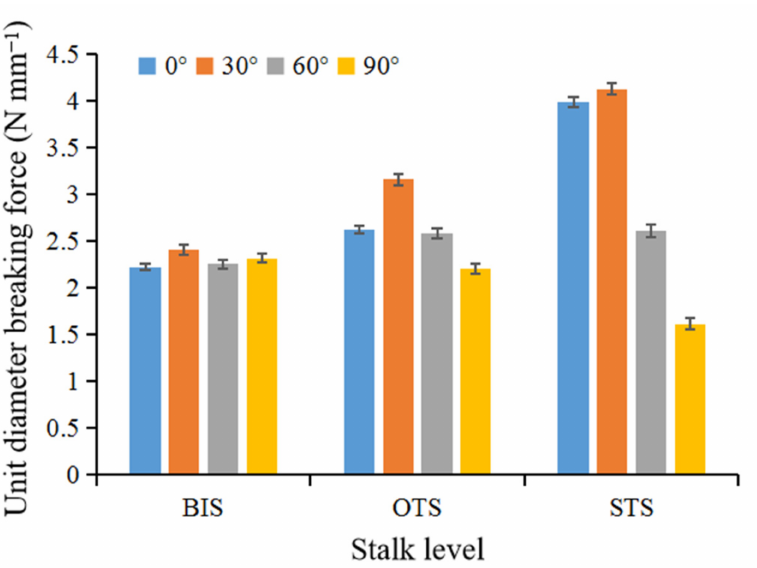
Figure 10. Tensile force on tea stalks under different bending actions. BIS: stalks between buds and leaves; OTS: one and two leaves interstitial stalks; STS: stalks between the second and third leaves.